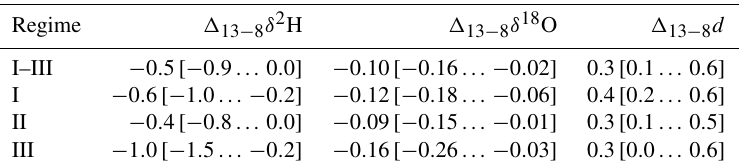
Table A2. Vertical SWI gradients for the three wind regimes: (I) low wind speed < 6ms − 1 , (II) intermediate wind speed between 6ms − 1 and 16ms − 1 , (III) high wind speed > 16ms − 1 . The gradients are given in ‰m − 1 . In brackets, the 65% percentile ranges are